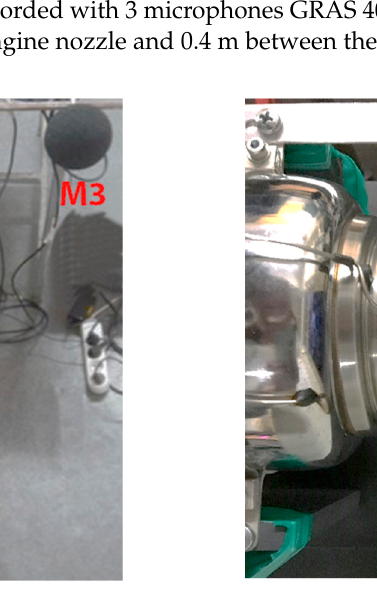
Figure 1. Test bench and instrumentation.